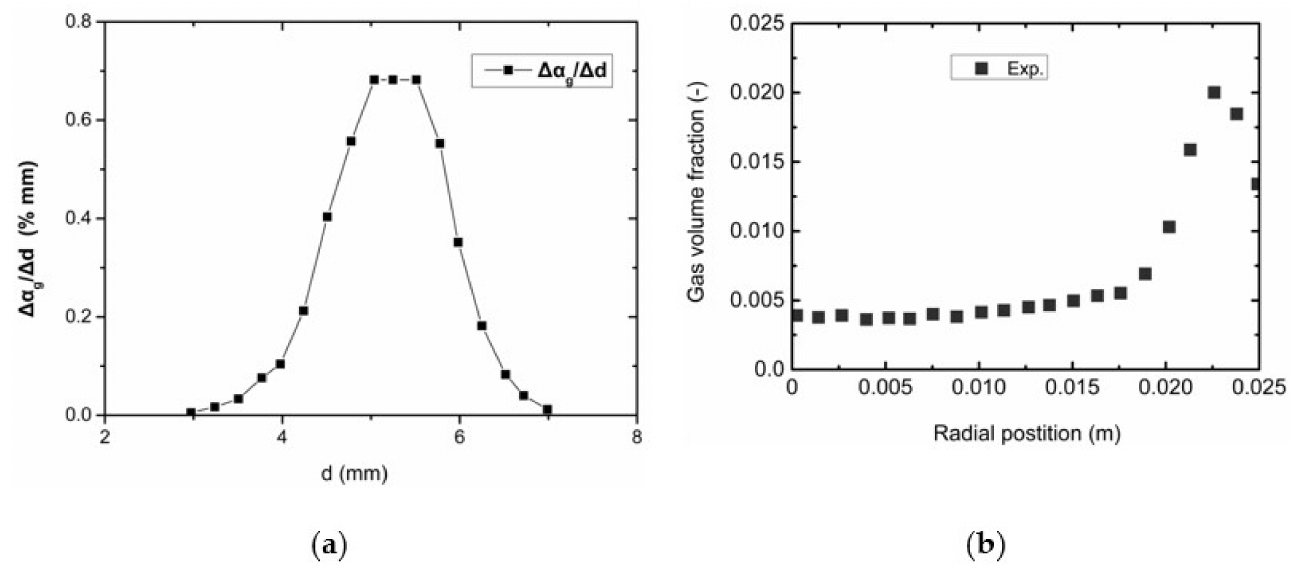
Figure 8. Experimental data [51]. ( a ) Histogram of bubble diameter distribution (left). ( b ) Distribution of gas volume fraction along the pipe radius